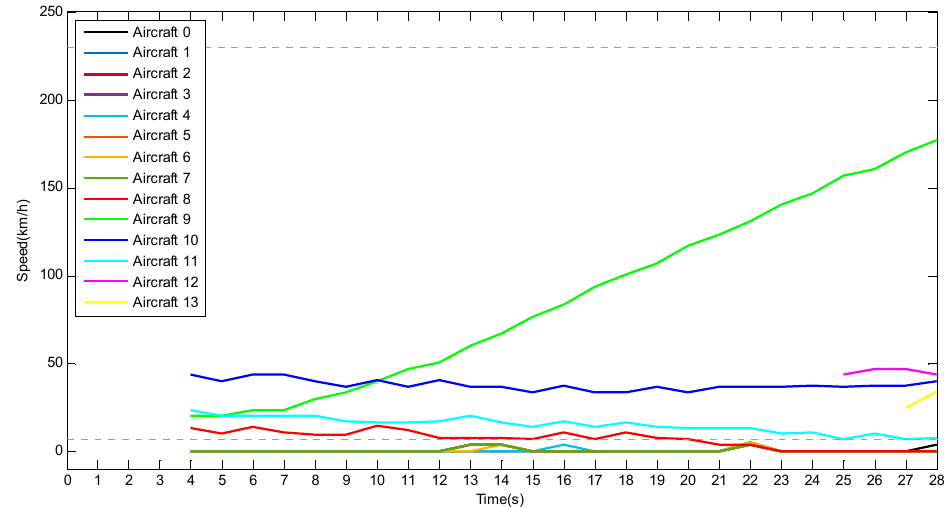
Figure 12. Speed measurements for each aircraft in test Video 2. Figure 13. Speed measurements for each aircraft in test Video 2.